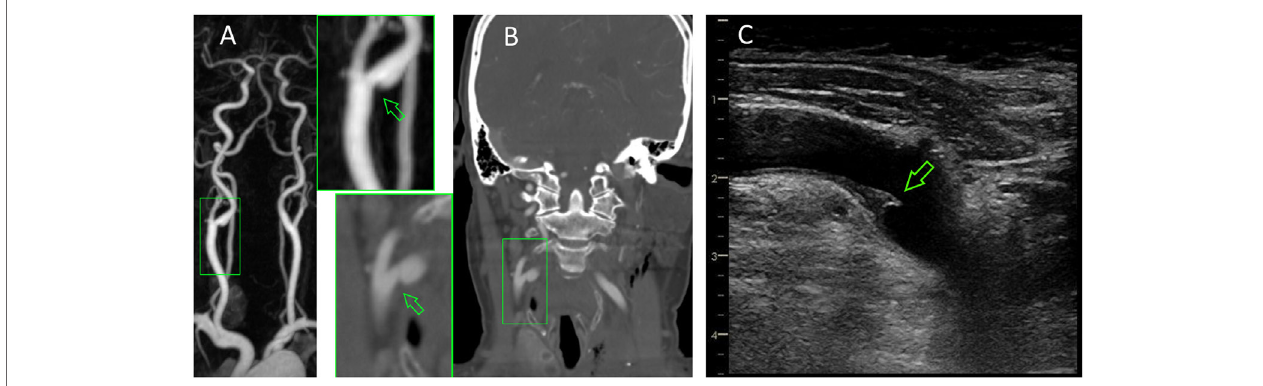
FiGURe 3 | Irregular-shaped plaque formation at the origin of the ipsilateral internal carotid artery (arrows) as seen in contrast-enhanced MRA (a) , computed tomography angiography (B) , and neurosonography (C)